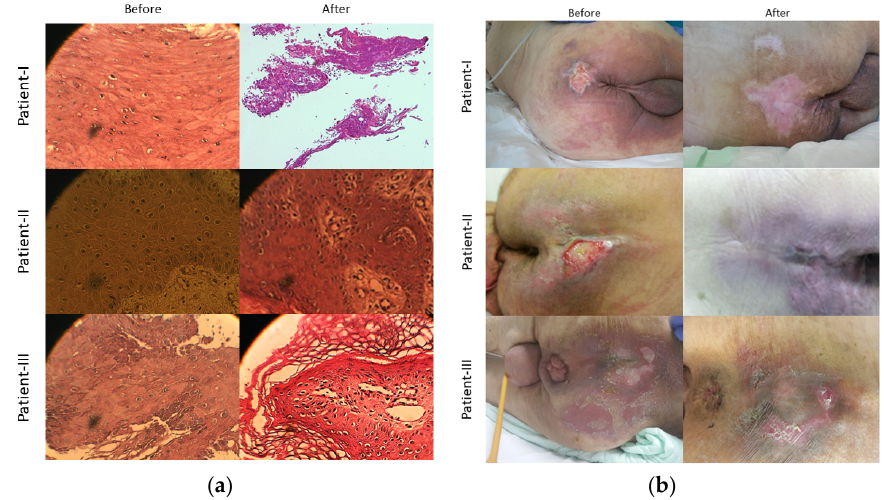
Figure 1. Images were taken on the sacrococcygeal area and represent the histological condition of the PU ( a ). Visual observation of wound area ( b ).